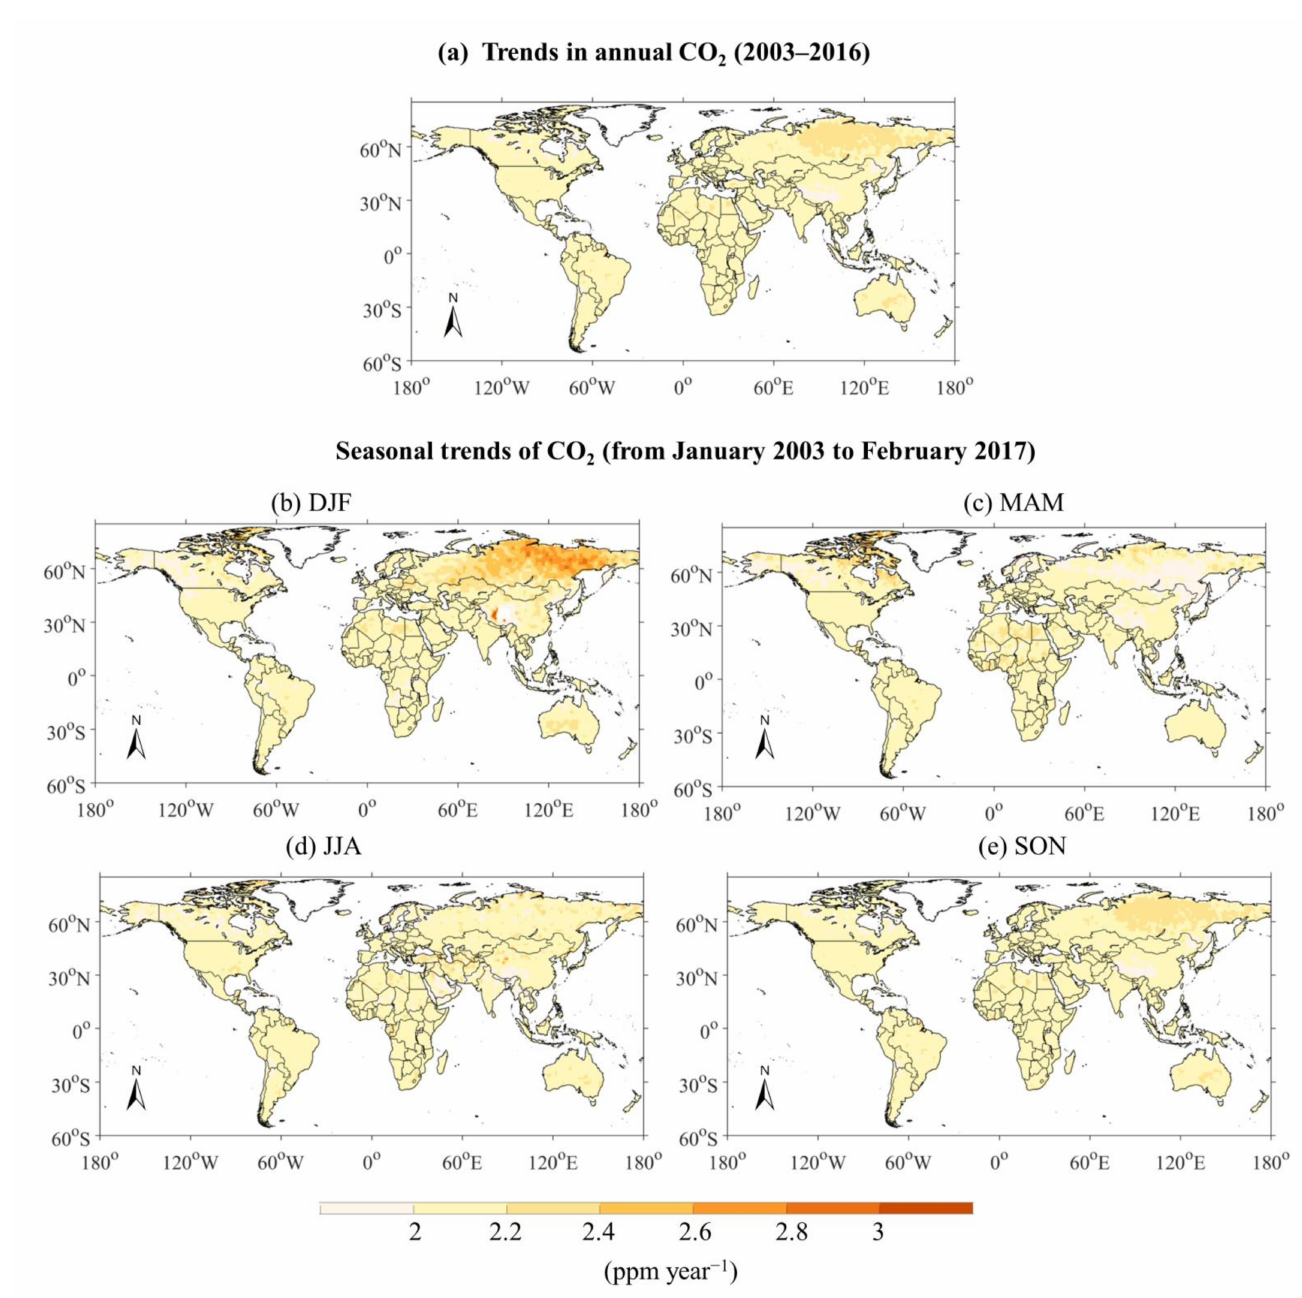
Figure 6. ( a ) Spatial patterns of trends in annual CO 2 during 2003–2017 over each 1 ◦ grid cell; ( b – e ) seasonal trends of CO 2 from January 2003 to February 2017. DJF represents December, January, and February; MAM represents March, April, and May; JJA stands for June, July, and August; and SON represents September, October, and